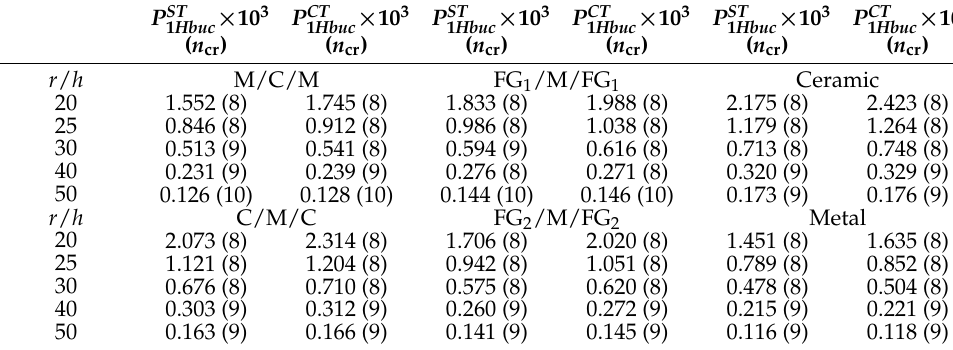
Table 3. Variations in P CT , P ST and ( n cr ) of various kinds of sandwich and single-layer cylindri- 1 Hbuc 1 Hbuc cal shells under clamped boundary conditions versus the r / h